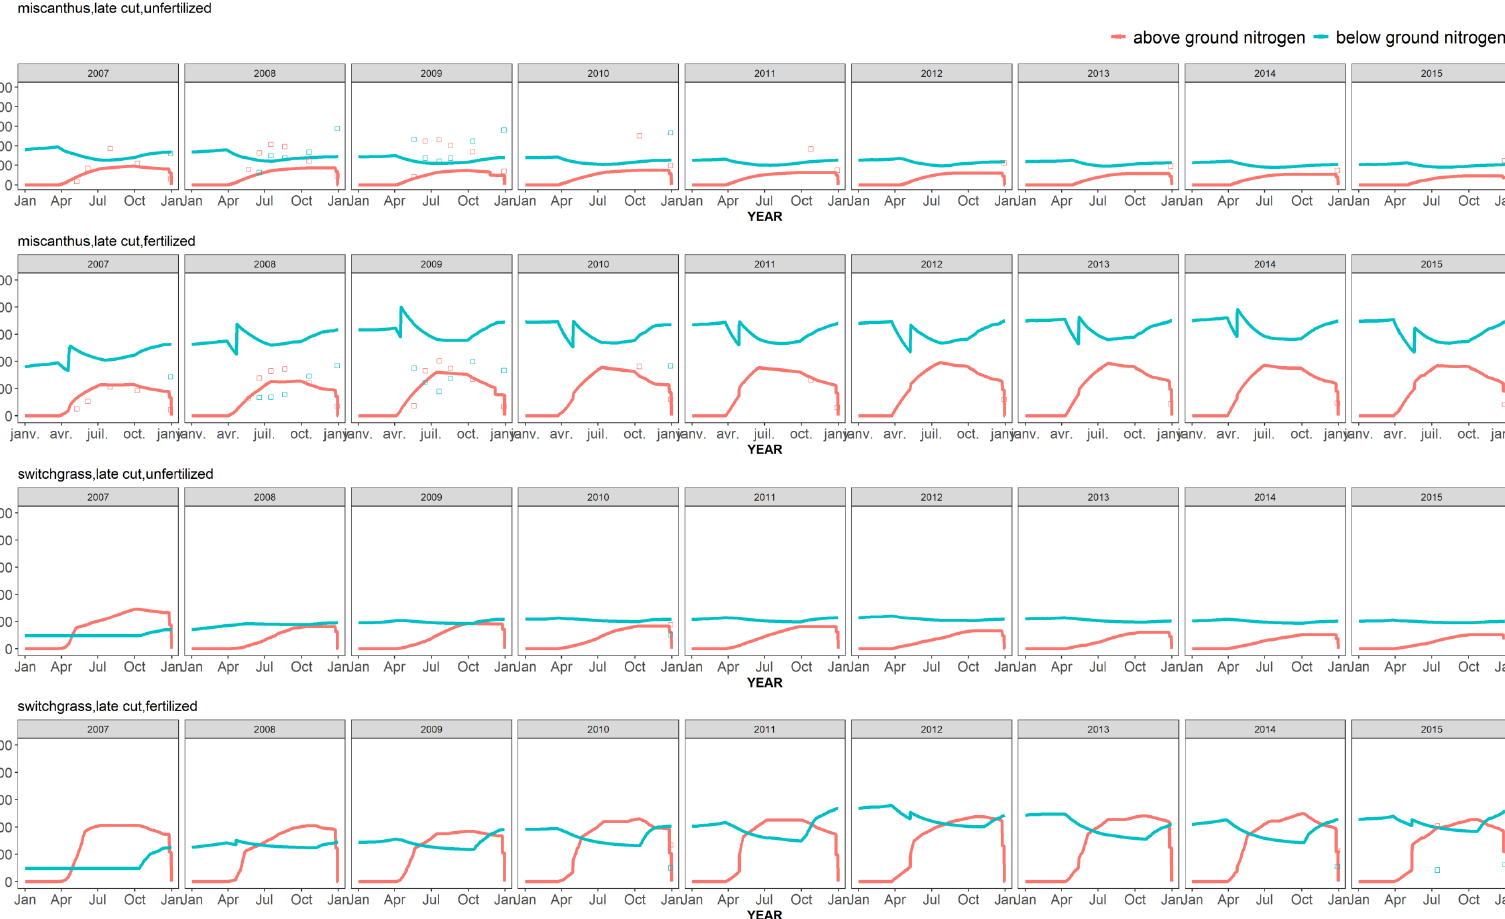
Figure 3. Simulated (lines) and observed (symbols) dynamics of nitrogen in the above and below-ground plant compartments for two treatments of the switchgrass and miscanthus crops in Estrées-Mons.